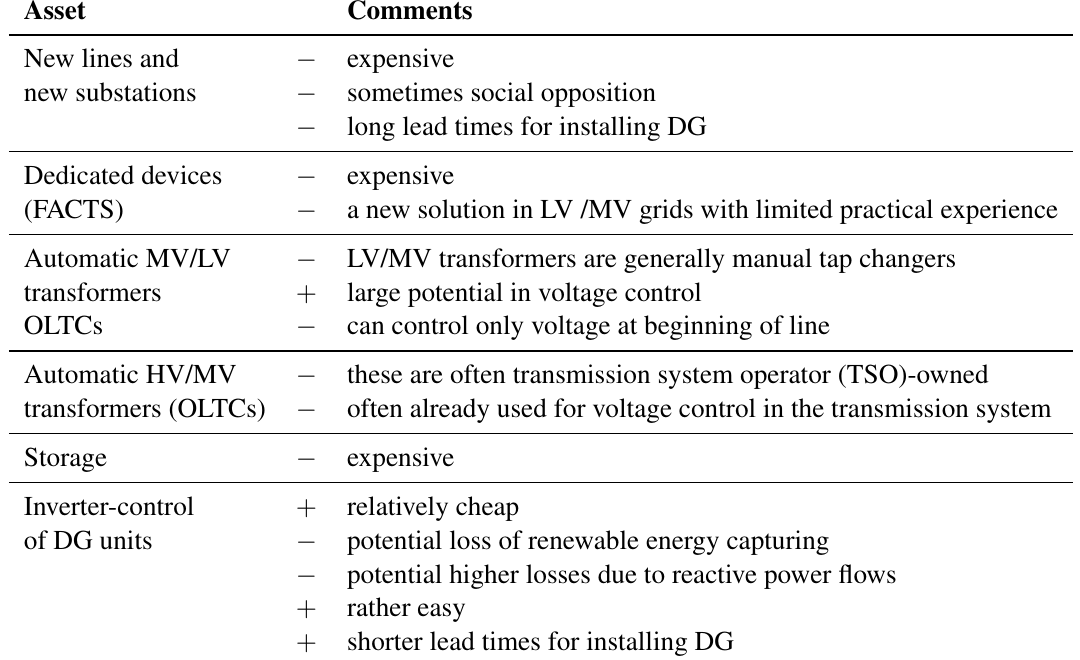
Table 1. Solutions for voltage congestion issues. DG, distributed generation; FACTS, flexible AC transmission system; MV, medium